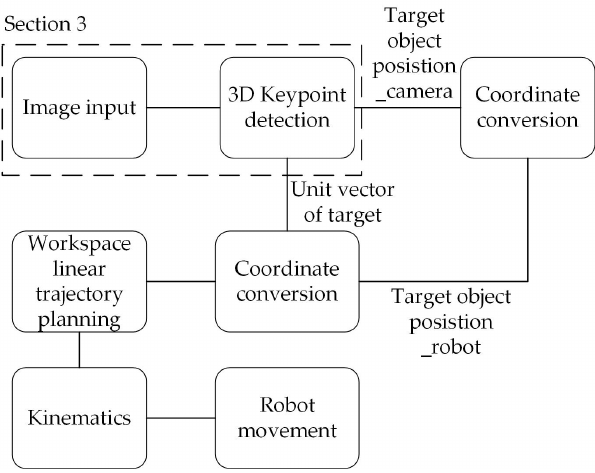
Figure 7. Flowchart of robot manipulator operation